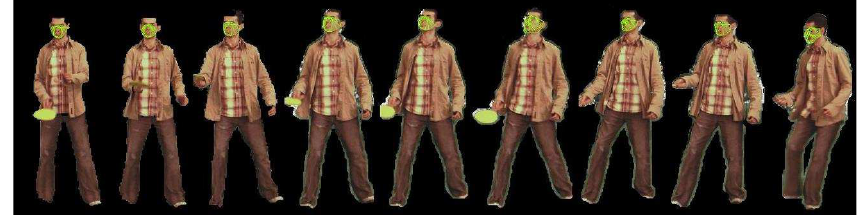
Figure 7. Samples of the segmented cVSG corpus image sequences fitting the different AAM